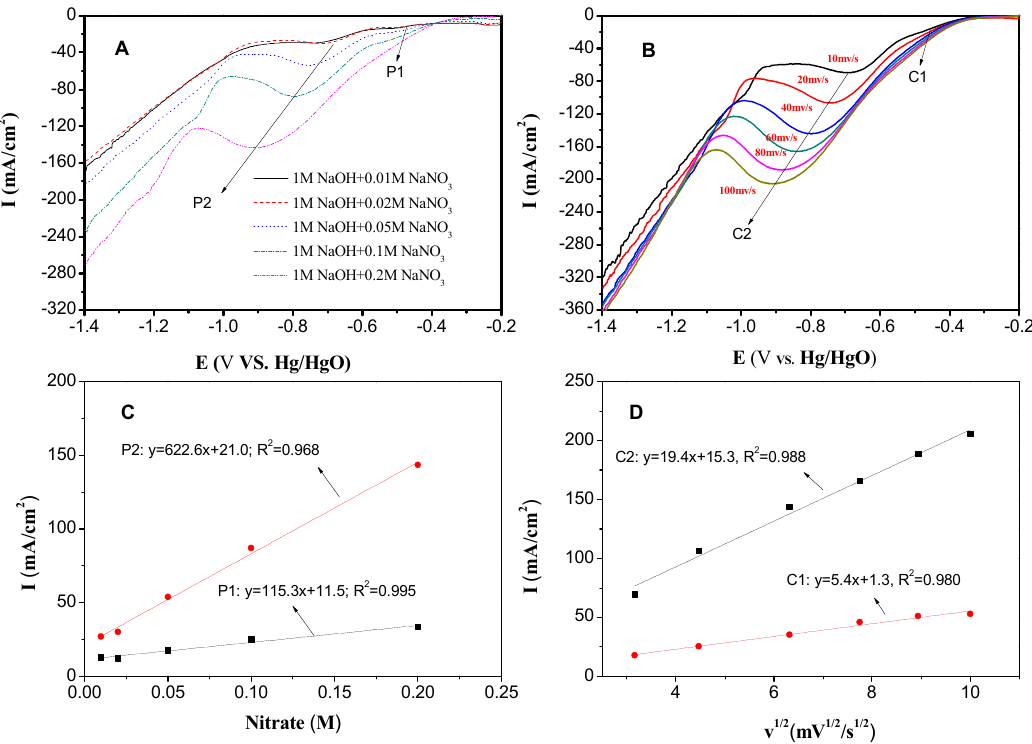
Figure 5. LSV curves of Cu 2 CoAl-HTLC in alkaline solution under various: nitrate concentrations ( A ) & scan rates ( B ); Linear relationship between peak currents and nitrate concentrations ( C ) & root of scan rates ( D ).